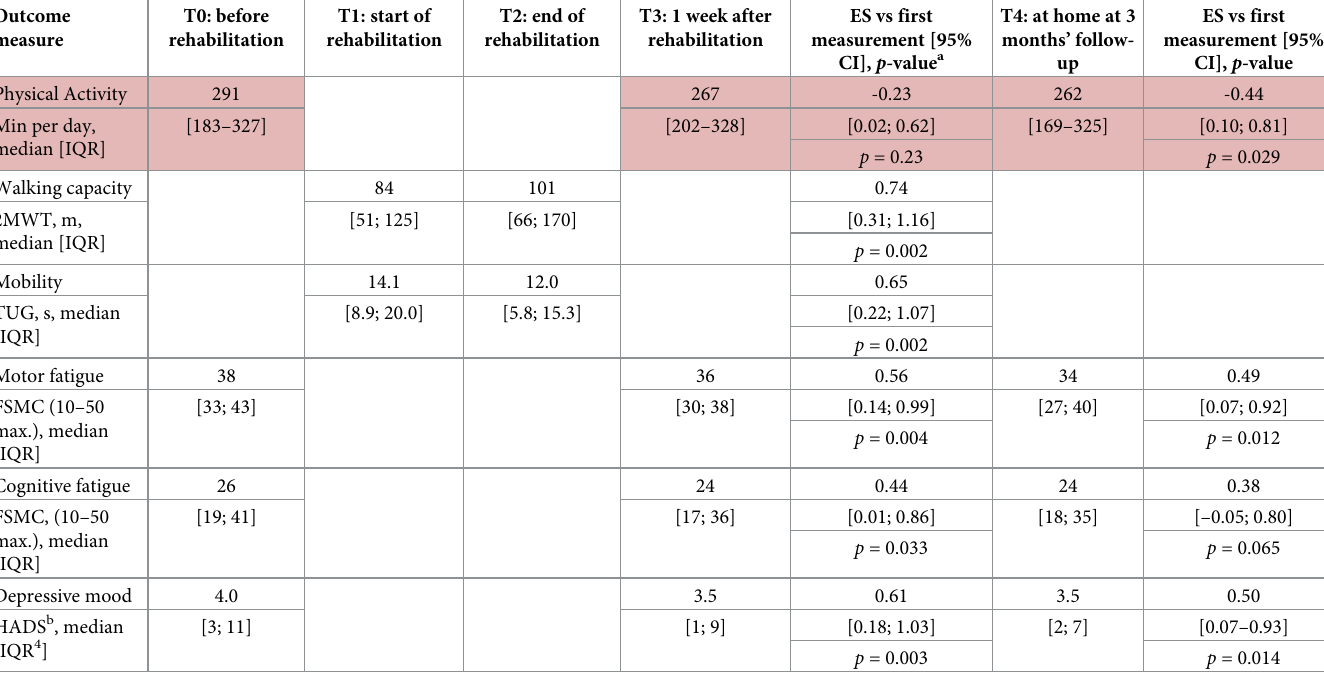
Table 2. Physical activity, walking capacity, mobility, and mood before and after rehabilitation and at 3 months’ follow-up.